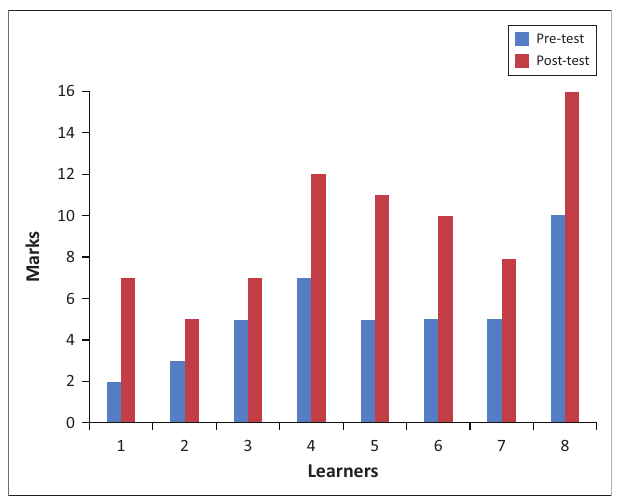
FIGURE 3: Test results of the baseline assessment out of a total mark of